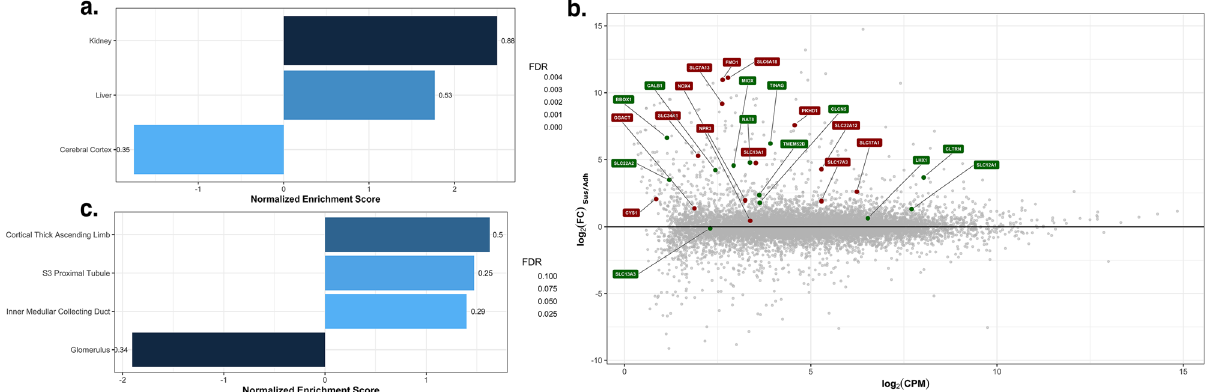
Figure 6. ( a ) HPA tissue related gene set enrichment analysis of Sus_CDM2 samples compared to Adh_CDM2 samples (FDR < 0.05). Tissue profiles were developed with the package TissueEnrich. Only tissue enriched genes were selected for the profiles, and only profiles with size of at least 5 specific genes were considered for the analysis. The proportion of the genes related to that profile and contributing to the enrichment scores are annotated at the side of the bars. The coloring of the bars depicts the FDR values according to the legend on the right side of the figure. ( b ) MD plot of identified kidney enriched genes with LFC and log(CPM) values. Green and red labels renal tubules or kidney associated genes according to Human Protein Atlas database, respectively. ( c ) Identification of renal tubule segment specific expression pattern. Segment related gene set